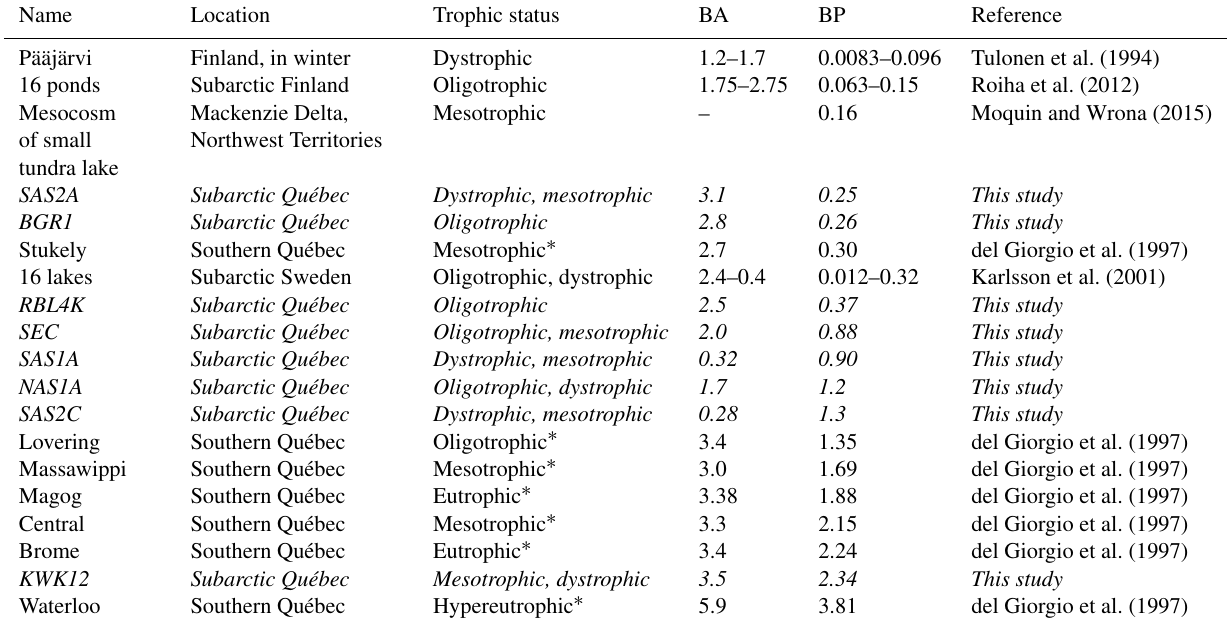
Table 5. Comparison of bacterial abundances (BA, 10 6 cells mL − 1 ) and production rates (BP, µg CL − 1 h − 1 ) from thermokarst lakes with other aquatic environments. ∗ Trophic status based on Chl a concentrations